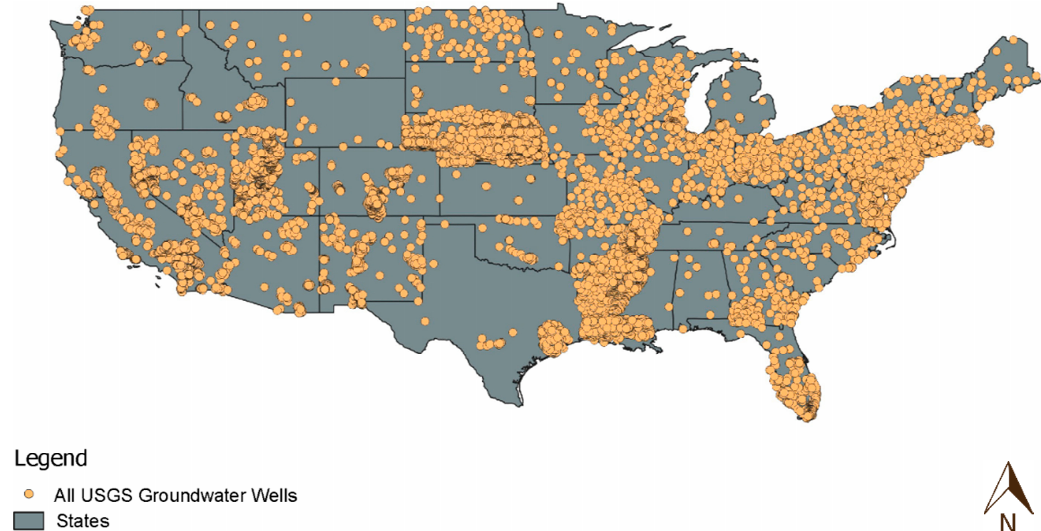
Figure 2. USGS well locations within the United States.